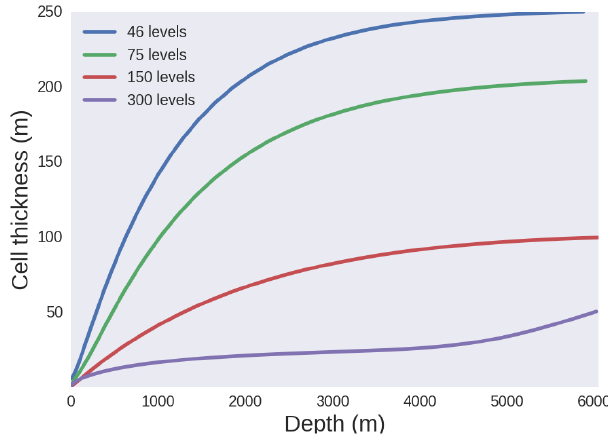
Figure A1. Grid cell thickness as a function of depth for the four vertical grids used in the